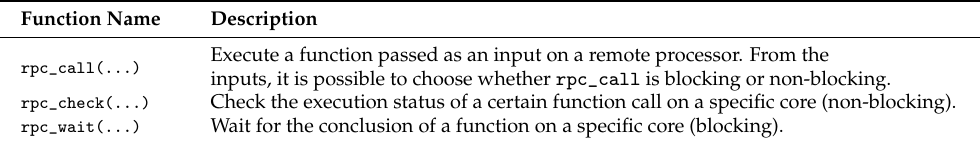
Table 5. Call functions, used by the ADAM system to manage the execution of tasks on the